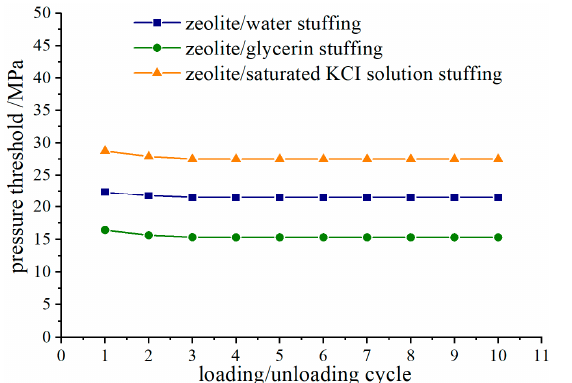
Figure 4. Pressure thresholds of the three kinds of zeolite-based stuffing under ten cyclic loadings (ZSM-5 zeolite/water stuffing, ZSM-5 zeolite/glycerin stuffing, and ZSM-5 zeolite/saturated KCl solution stuffing).